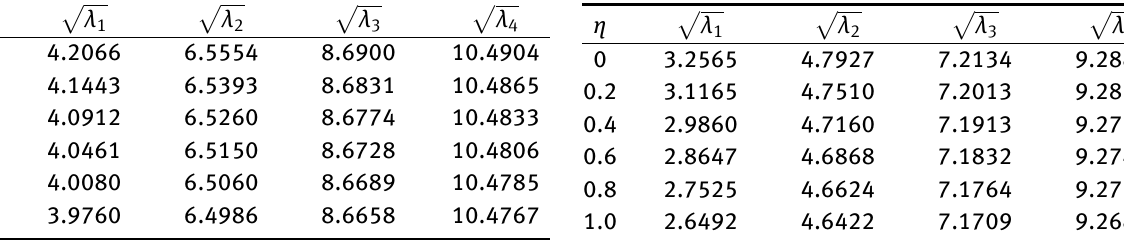
(︁ √ )︁ for CF case for different non- λ